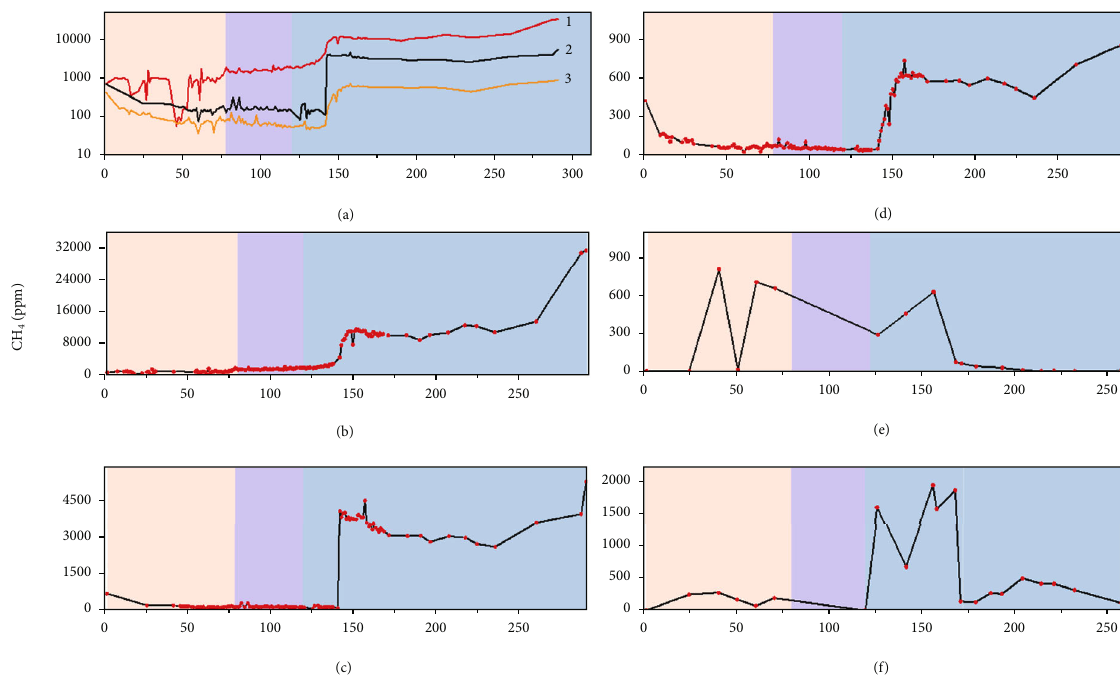
Figure 8: CH concentration in di ff erent central points: (a) layers 1-3; (b) layer 1; (c) layer 2; (d) layer 3; (e) layer 6; (f) layer 4